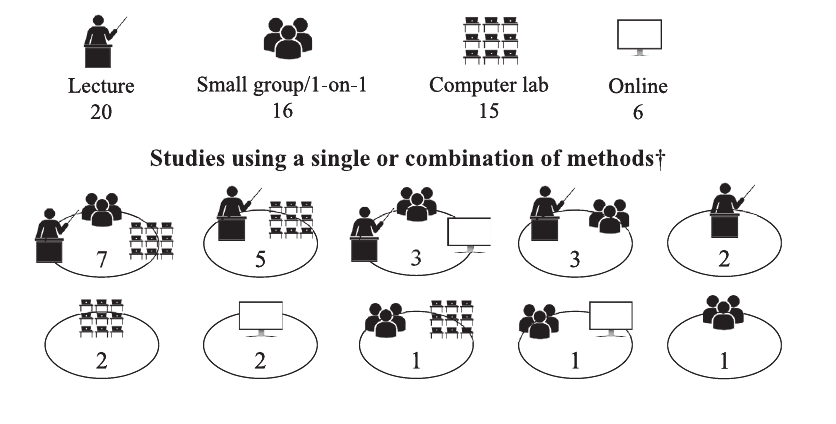
Figure 3 Methods of